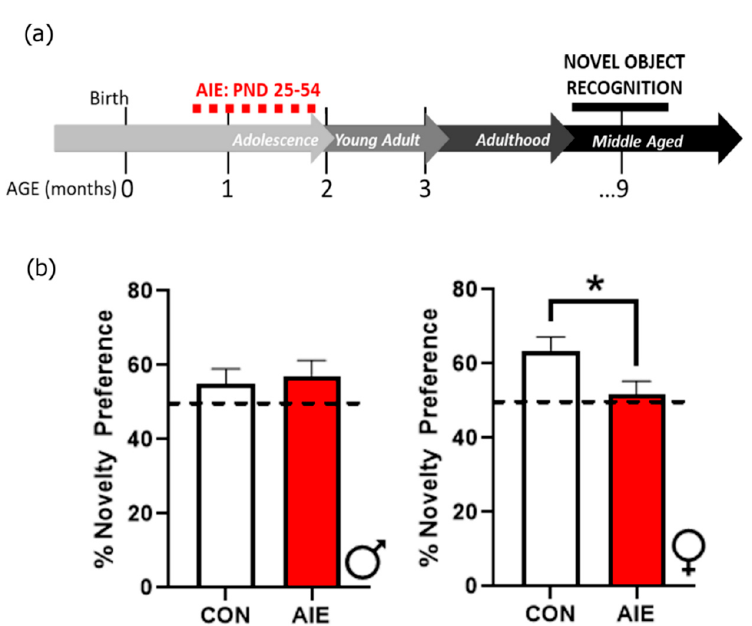
Figure 6. AIE impairs novel object recognition (NOR) in middle age female rats. ( a ) Timeline for NOR. Rats underwent AIE or CON gavage paradigms from PND 25–54. The NOR test was conducted later in adulthood (9 months of age). Males were tested first, followed by females. ( b ) Even in middle age, female rats that were exposed to AIE more than 7 months prior continue to show cognitive deficits, as evidenced by lack of discrimination in the percentage of time spent between novel and familiar objects. Results are expressed as mean ± SEM. * p < 0.05.